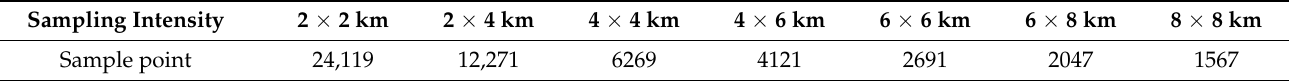
Table 6. Number of sample points per sample